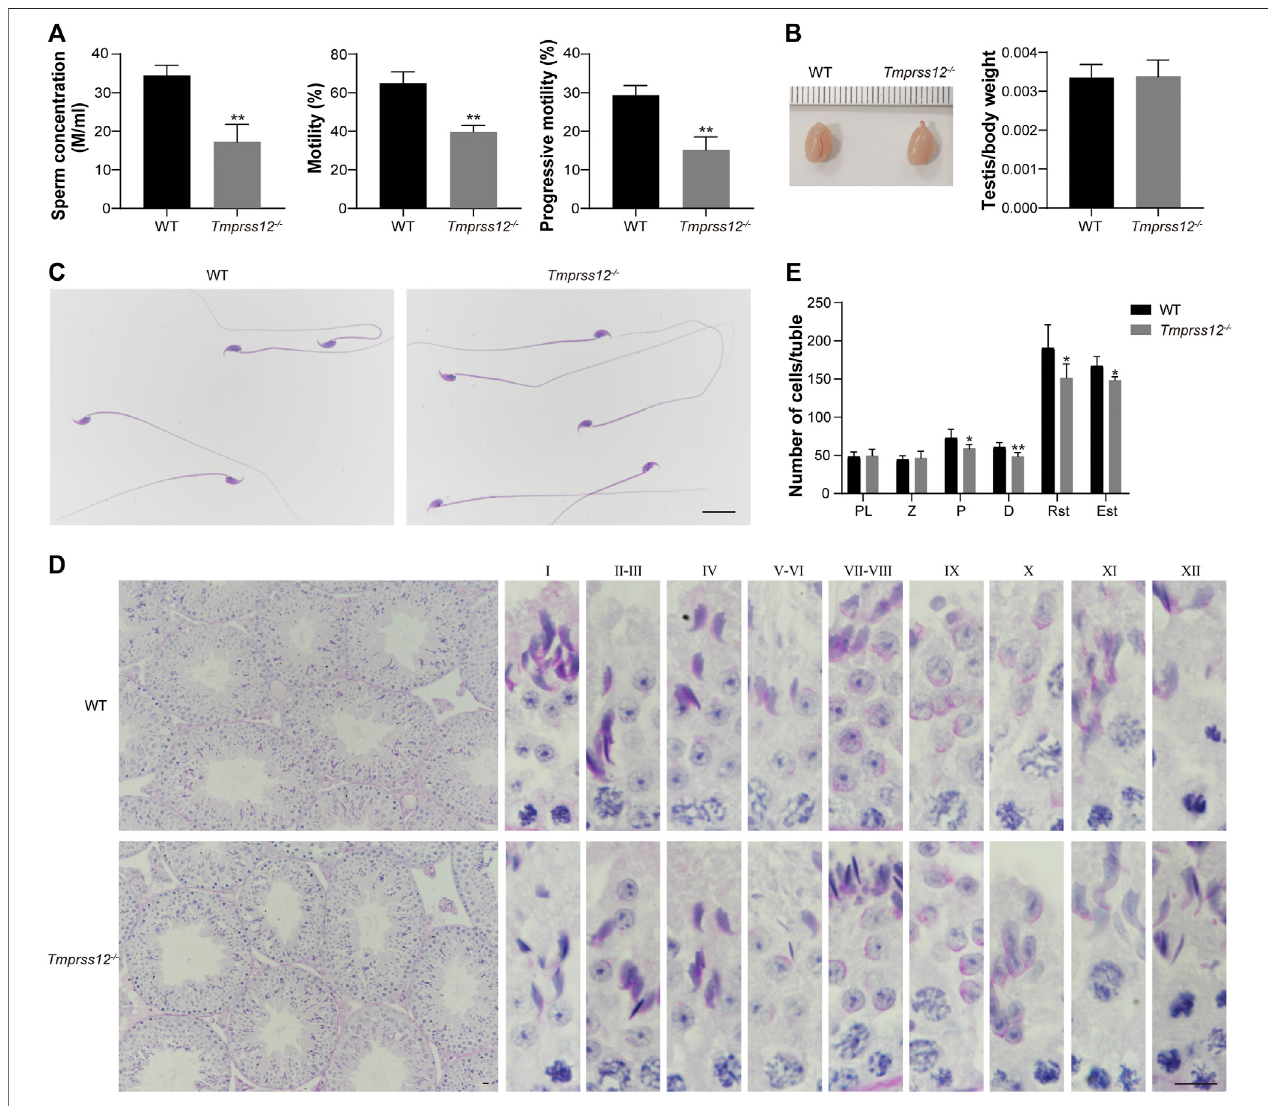
0.01. (B) GrossmorphologyoftestesfromWTand Tmprss12 − / − miceandrelativetestisweighttobodyweightinthetwogroupsshowednosigni fi cantdifference( n =3). Data are the mean ± s.d. (C) The sperm morphology of WT and Tmprss12 − / − mice. The sperm of Tmprss12 − / − mice showed no obvious abnormality. Scale bar: 20 µm. (D) Periodic acid-Schiff staining of testis sections from WT and Tmprss12 − / − mice. Complete spermatogenic tubules and orderly arranged spermatogenic cells couldbeseeninthetestesof Tmprss12 − / − mice.Scalebar:10 µm. (E) Reducednumberofspermatogeniccellsin Tmprss12 − / −